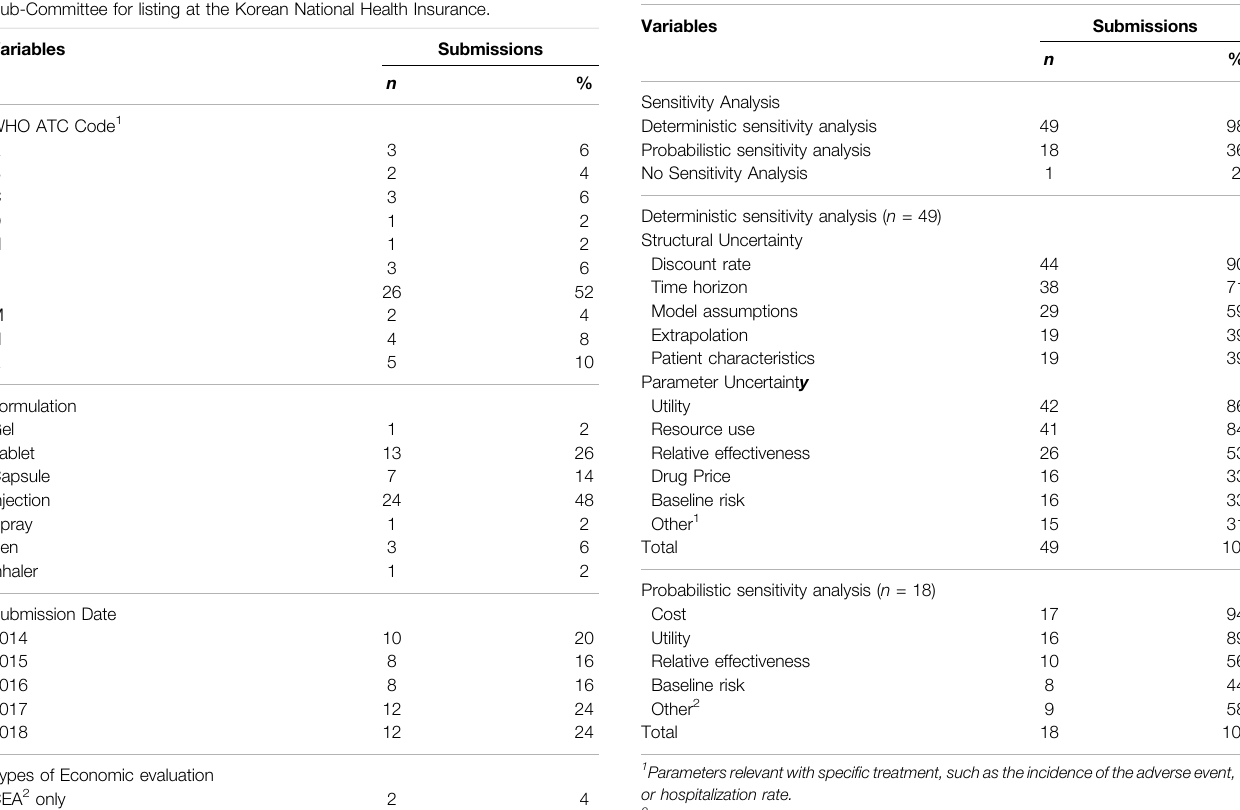
TABLE 2 | Types of sensitivity analysis of the 50 dossiers